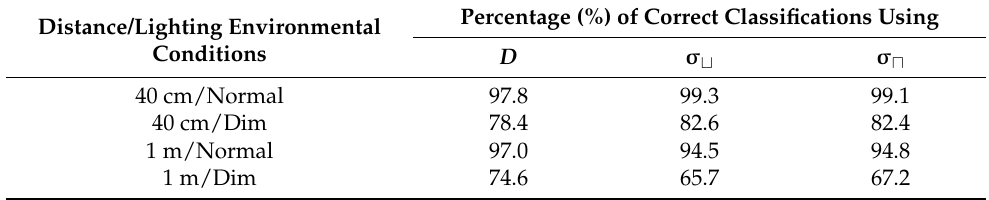
Table 5. Results by the optimized GbCtree classifier for four different environmental conditions. Distance/Lighting